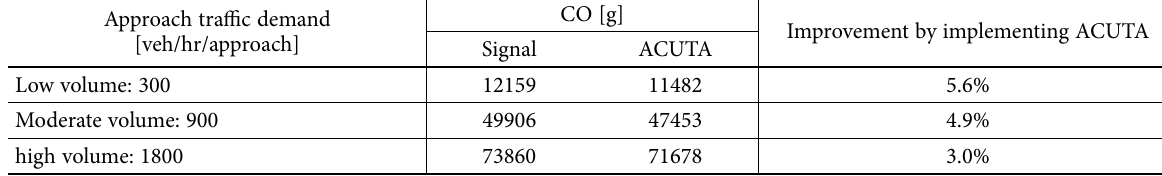
Table 3. Comparison of CO emission between multi-tile ACUTA and signal control